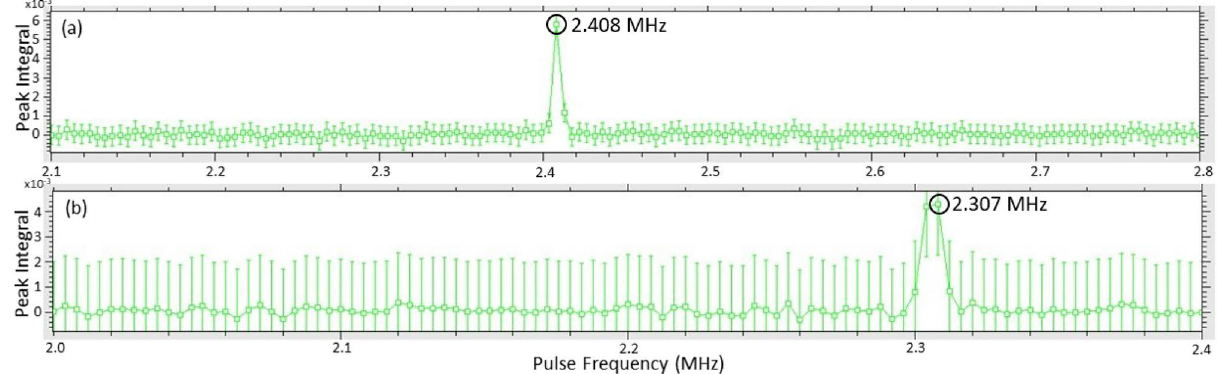
Figure 11. Results of frequency sweeps used to detect 14 N NQR frequencies in the 2–3 MHz range for: ( a ) Benzocaine, and ( b ) Nicotinamide. The detected resonances are labeled using arrows.